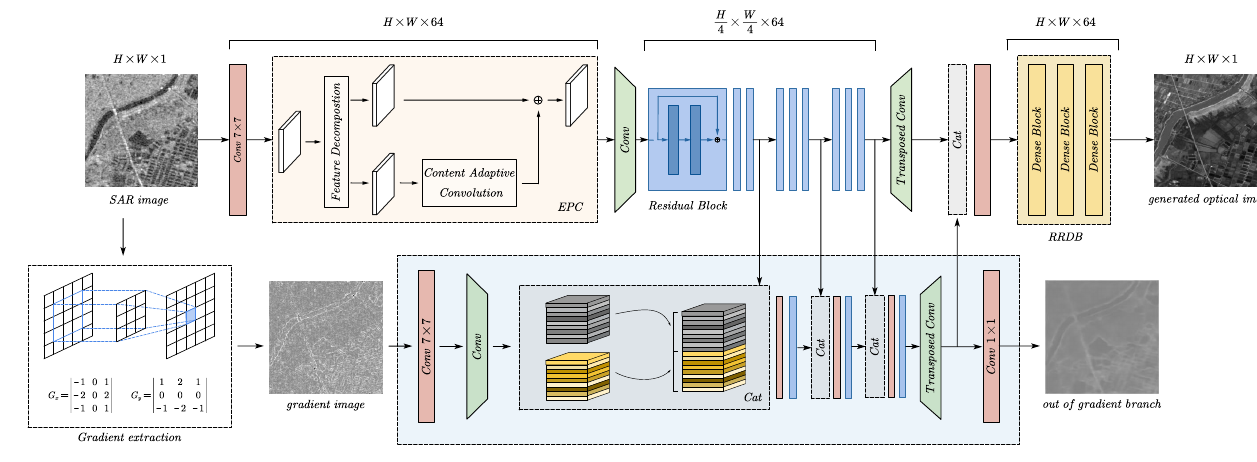
Figure 4. The generator of EPCGAN. The generator shown is for SAR-to-optical translation. The gradient branch aims to resolve the SAR image gradient map with its the optical image counterpart. It combines multi-level auxiliary information from the backbone network to reduce parameters and outputs gradient information to assist the generation of the final optical